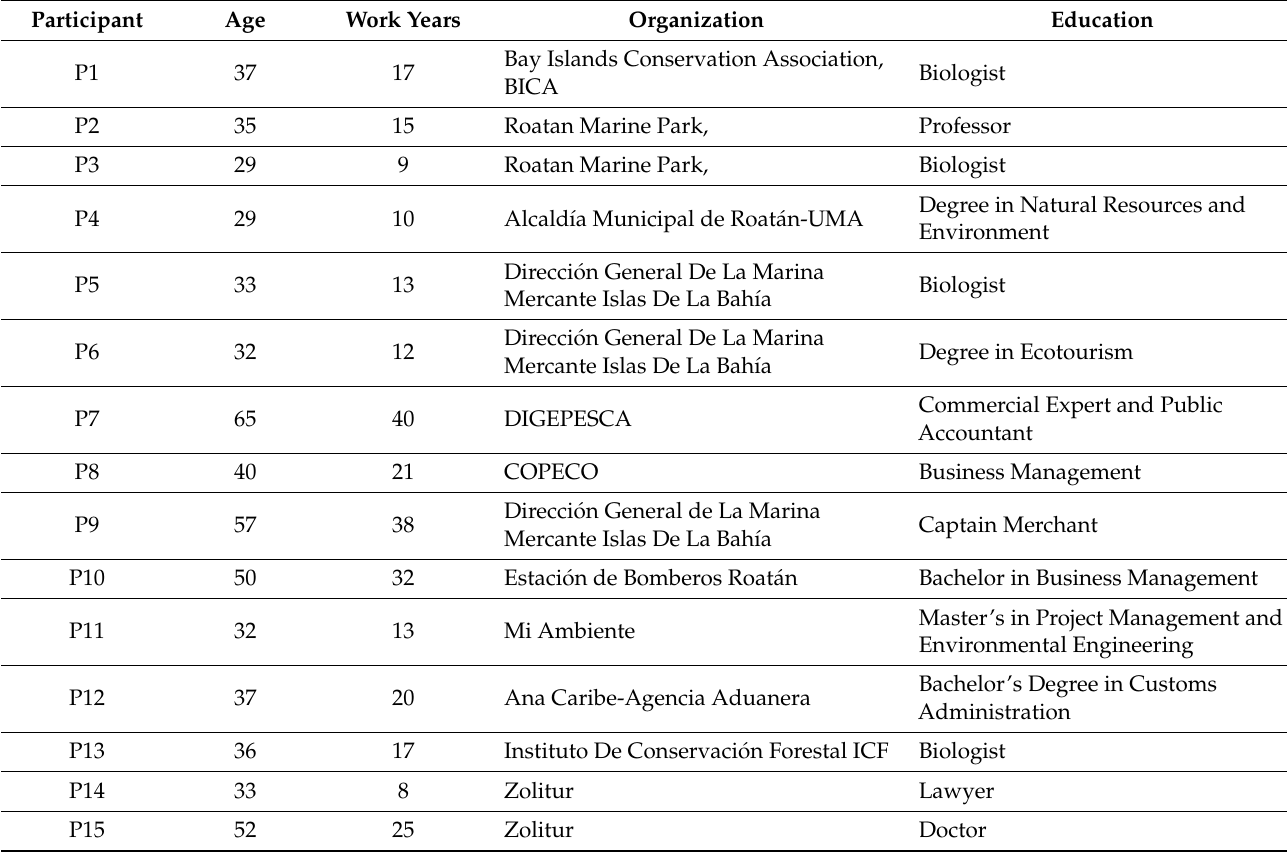
Table 3. Some information about the